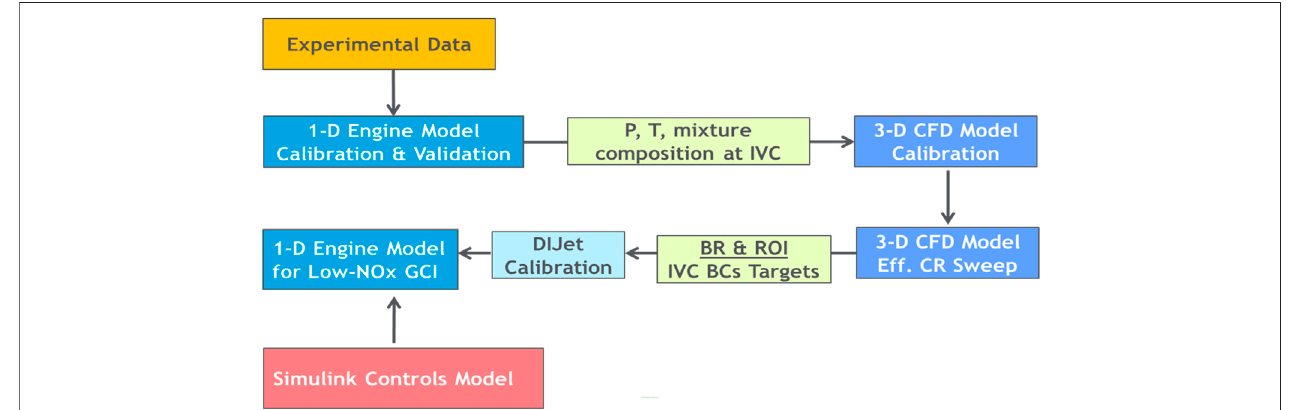
FIGURE 2 | 1-D and 3-D model coupling methodology.